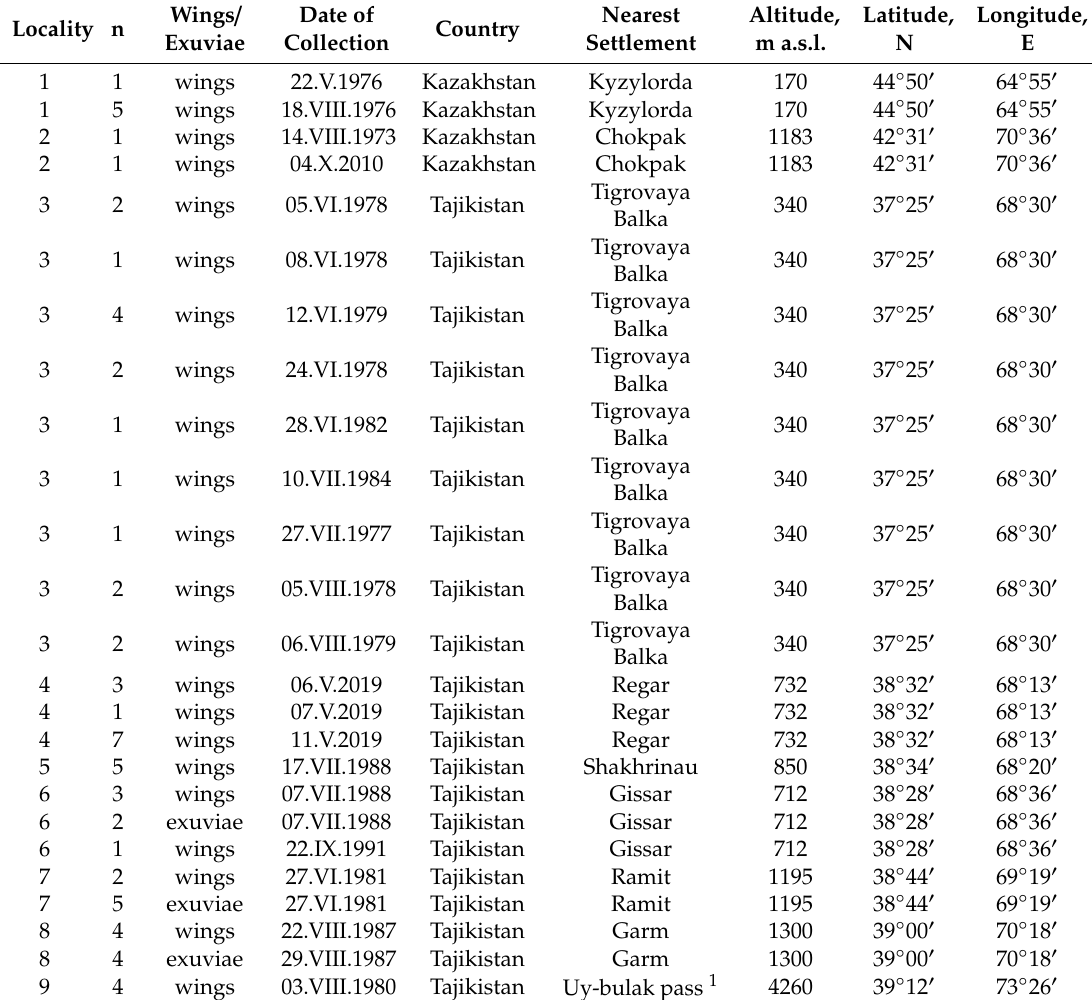
Table 1. Localities and dates of collection of Pantala flavescens in Middle Asia (see Figure 1). Locality